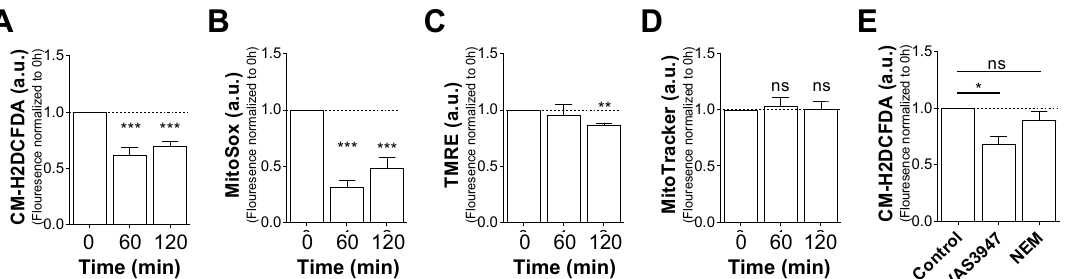
Figure 6. E ff ect of VAS3947 on cytoplasmic and mitochondrial reactive oxygen species (ROS) production Figure 6. Effect of VAS3947 on cytoplasmic and mitochondrial reactive oxygen species (ROS) in MV-4-11 cell line. E ff ect of VAS3947 (4 µ M) on ( A ) cytoplasmic ROS production measured production in MV-4-11 cell line. Effect of VAS3947 (4 µM) on ( A ) cytoplasmic ROS production by 5-(and-6)-chloromethyl-2 (cid:48) ,7 (cid:48) -dichlorodihydrofluorescein diacetate (CM-H2DCFDA) fluorescence; measured by 5-(and-6)-chloromethyl-2’,7’-dichlorodihydrofluorescein diacetate (CM-H2DCFDA) ( B ) mitochondrial ROS production measured by MitoSOX fluorescence; ( C ) mitochondrial membrane fluorescence; ( B ) mitochondrial ROS production measured by MitoSOX fluorescence; ( C ) potential measured by tetramethyl-rhodamine ethyl ester (TMRE) fluorescence; and ( D ) mitochondrial mitochondrial membrane potential measured by tetramethyl-rhodamine ethyl ester (TMRE) biomass measured by MitoTracker fluorescence. ( E ) E ff ect of VAS3947 (4 µ M) and NEM (8 µ M) on fluorescence; and ( D ) mitochondrial biomass measured by MitoTracker fluorescence. ( E ) Effect of cytoplasmic ROS production measured by CM-H2DCFDA fluorescence. ROS measurement at 0 h VAS3947 (4 µM) and NEM (8 µM) on cytoplasmic ROS production measured by CM-H2DCFDA ( A – D ) and control ( E ) was determined and established at 1. Data are shown as normalized fluorescence fluorescence. ROS measurement at 0 h ( A – D ) and control ( E ) was determined and established at 1. with respect to the control. Data are shown as mean ± SEM of n = 3 independent experiments. Student’s Data are shown as normalized fluorescence with respect to the control. Data are shown as mean ± t -test was performed comparing VAS3947 conditions to control (* p < 0.05; ** p < 0.01; *** p <